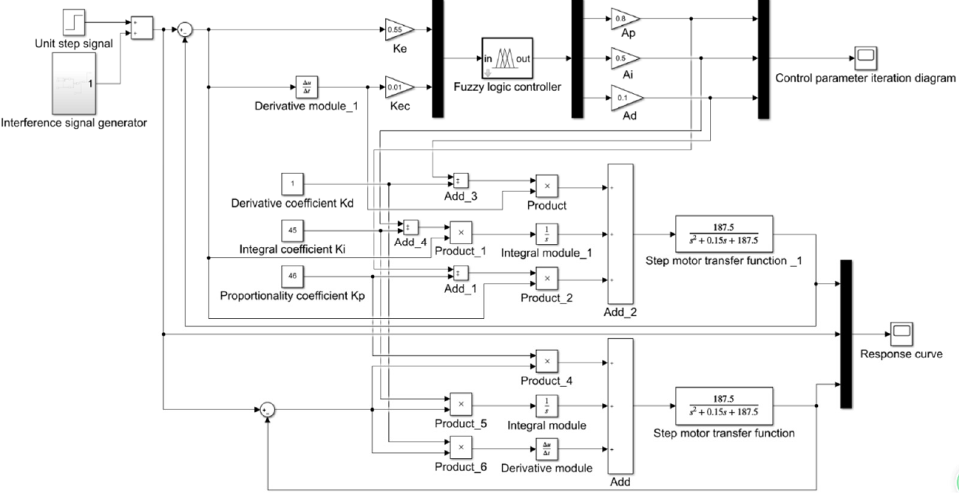
10 of 16 Figure 6. Control system step response graphs. 4.2. Control System Responsiveness under Disturbance Most of the automatic transplanters were used for field transplanting operations, which suffered from the impact of the ground environment, leading to the vibration of the automatic transplanter. The vibration led to the positioning error of the seedling mech-